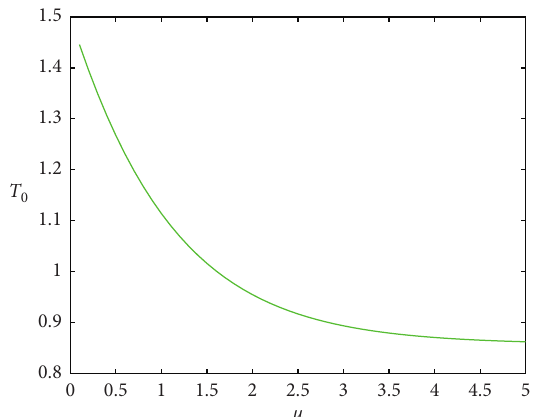
� 0.03, c � 0.1, τ � 0.005,